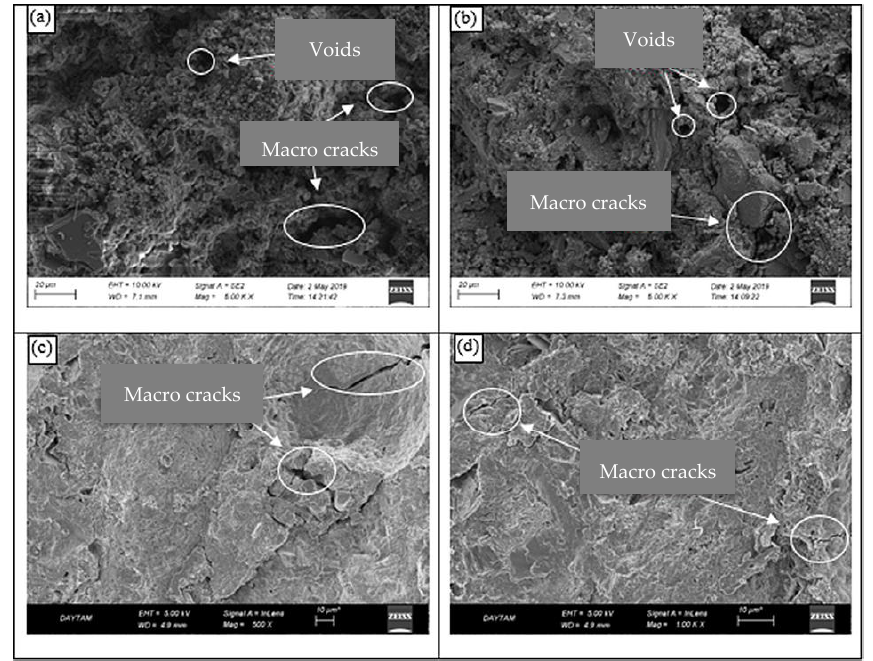
Figure 5. SEM micrographs of control and nano concrete samples after heating at 500 °C [31]. ( a )Con- trol sample, ( b ) 0.5% (NS + NA), ( c ) 1% (NS + NA), ( d ) 1.5% (NS + NA).